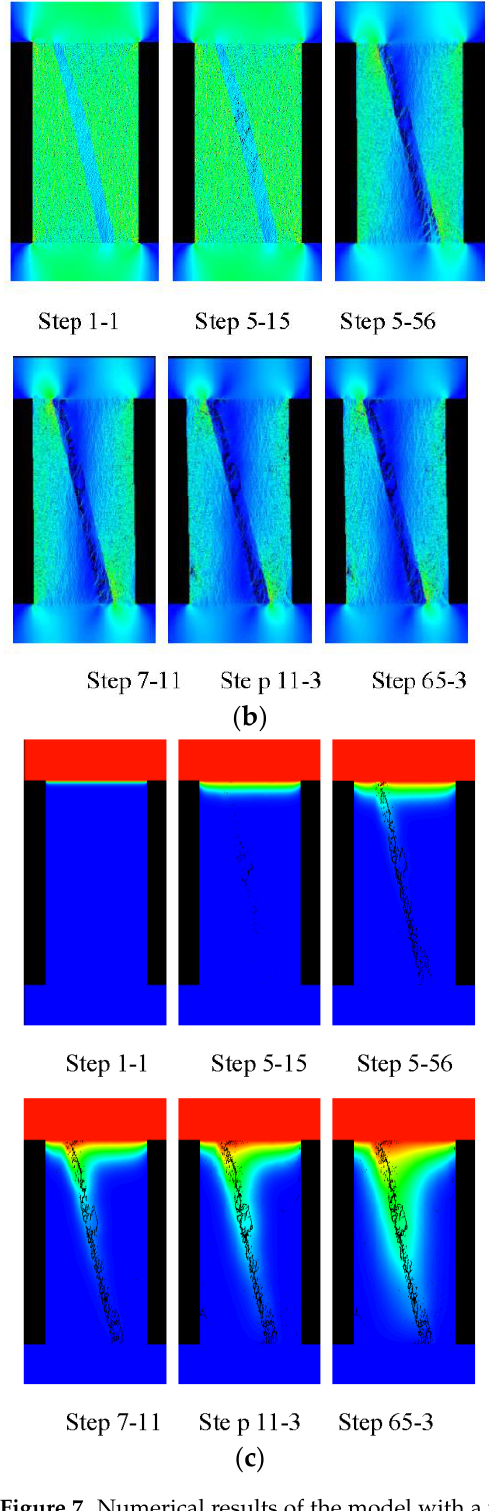
Figure 7. Numerical results of the model with a weak zone. ( a ) Whole process curve of load step- stress-permeability coefficient. ( b ) Presupposed weak zone model failure process stress results (MPa). ( c ) Results of water pressure distribution during crack formation (m).